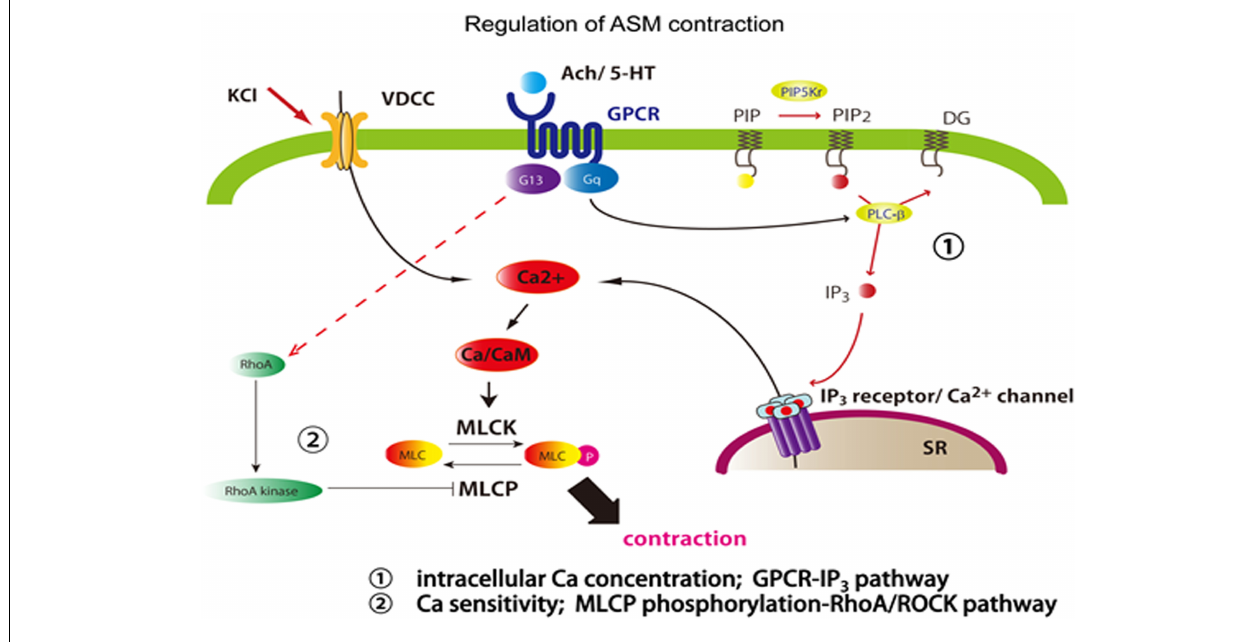
Rho-kinase which phosphorylates MLCP. pMLC phosphatase fails to dephosphorylate MLC. KCl, potassium chloride; Ach, acetylcholine; 5-HT, 5-hydroxytryptamine (serotonin); PIP, phosphatidylinositol 4-phos- phate; PIP2, phosphatidylinositol 4,5-bisphosphate; PIP5K, 1-phos- phatidylinositol-4-phosphate 5-kinase; DG, diacylglycerol; IP3, inositol